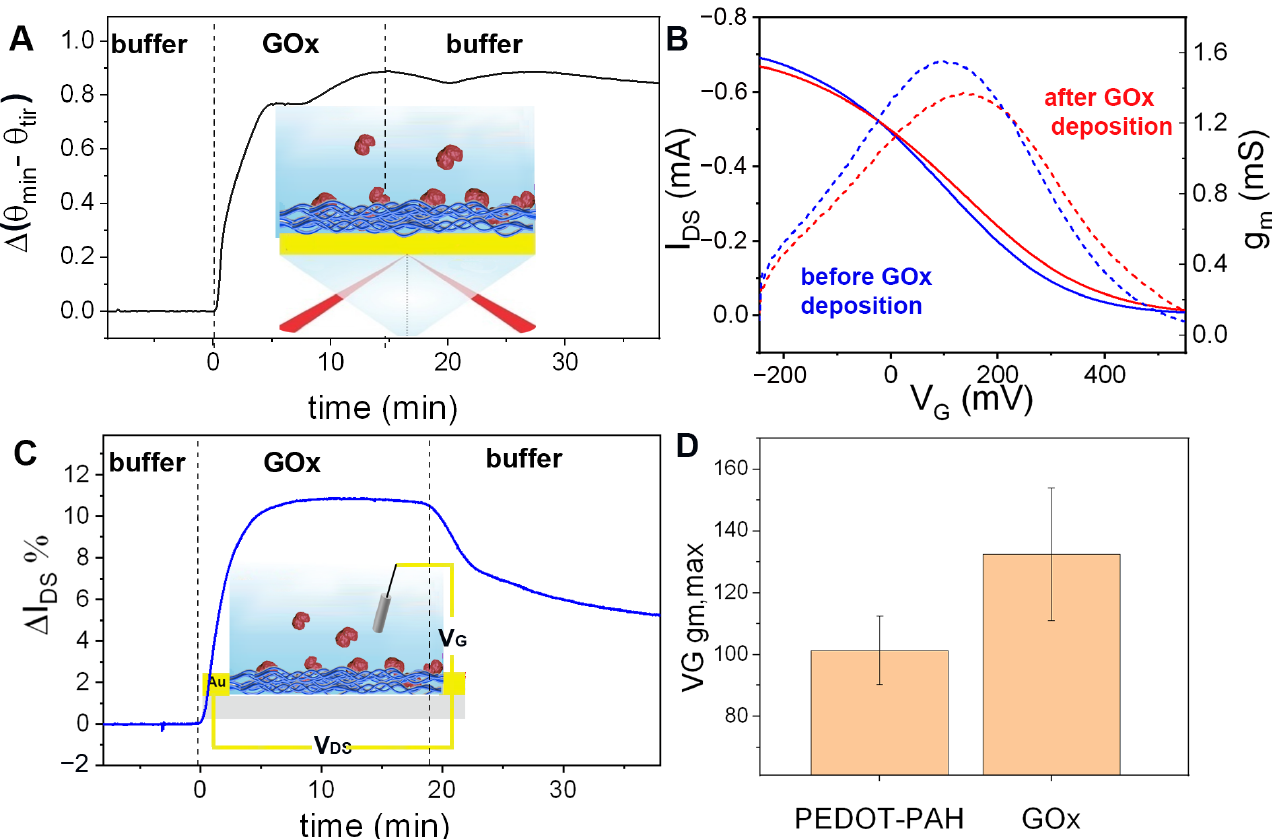
Figure 4. ( A ) Real time change in the SPR signal Δ(θ min –θ tir ) during GOx deposition on a gold sub- strate modified with PEDOT-PAH under flow conditions. ( B ) Transfer curves and g m vs. V G of a